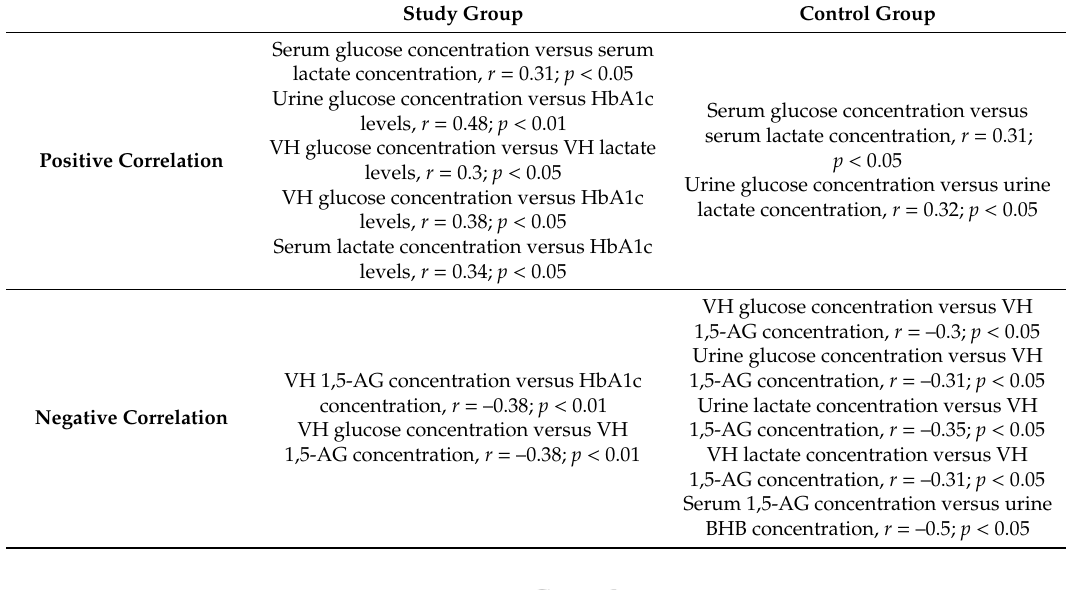
Table 14. Assessment of the correlation between concentrations of the analyzed markers in di ff erent study groups. Positive correlation: as the concentration of one marker increases, so does the concentration of the second marker; negative correlation: as the concentration of one marker increases, the concentration of the second marker decreases. HbA1c – glycated haemoglobin.